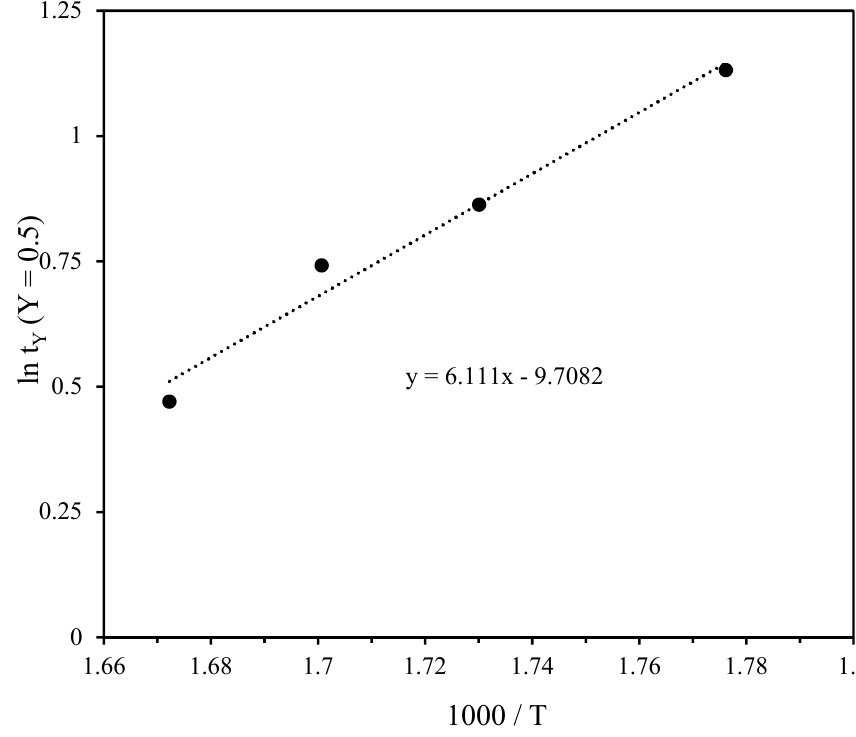
Figure 7. Arrhenius plot corresponding to the first mass t loss event (retained water).